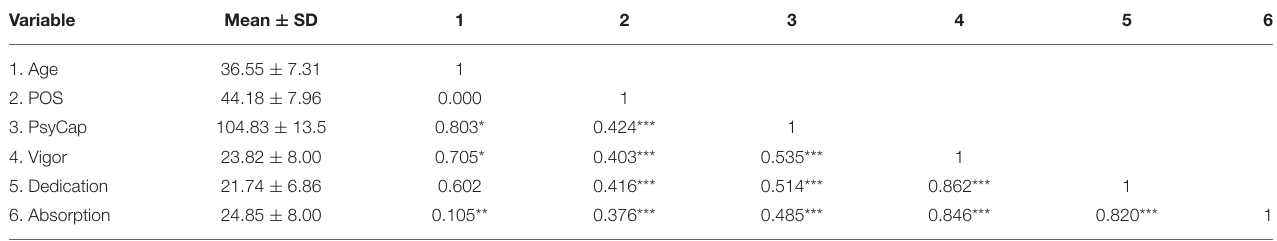
TABLE 2 | Correlations among study variables. Variable